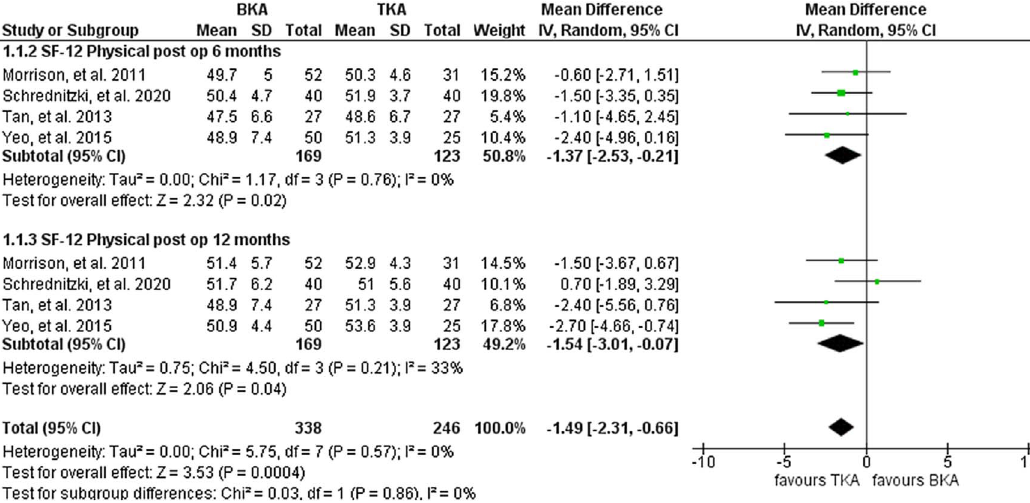
Figure 6. Forest plot of comparison: BKA vs TKA, outcome: SF-12 after 6 and 12